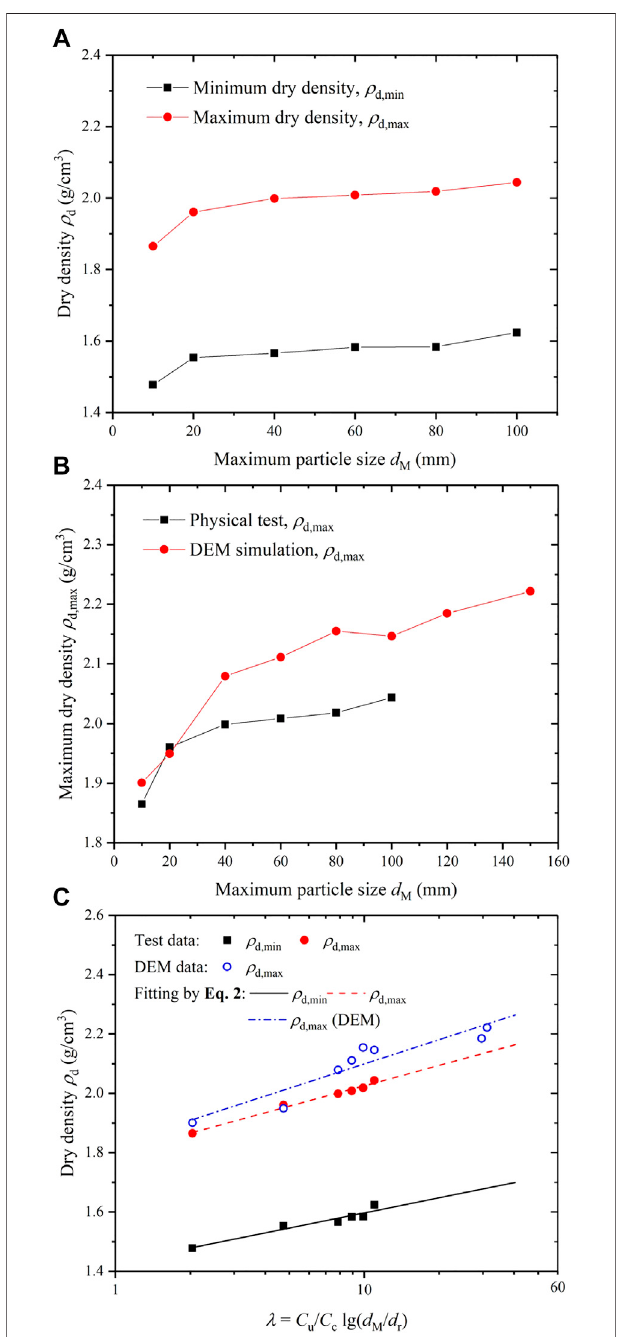
FIGURE 4 | (A) Relationship between the dry density ρ d and maximum particle size d M in physical dry densty tests; (B) comparison of dry density resultsinphysicaltestsandDEMsimulations; (C) relationshipbetweenthedry density ρ d and normalized parameter λ in physical tests and DEM